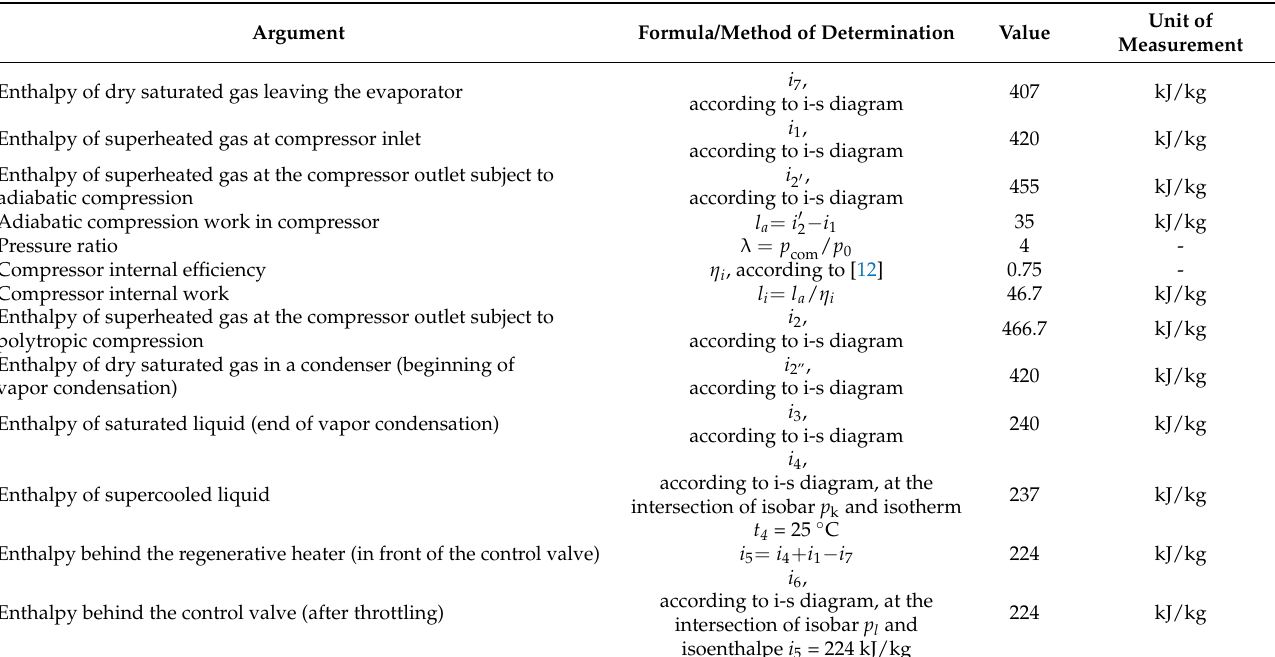
Figure 6. The diagram T-s. Table 1. Enthalpy values at characteristic points of a heat pump